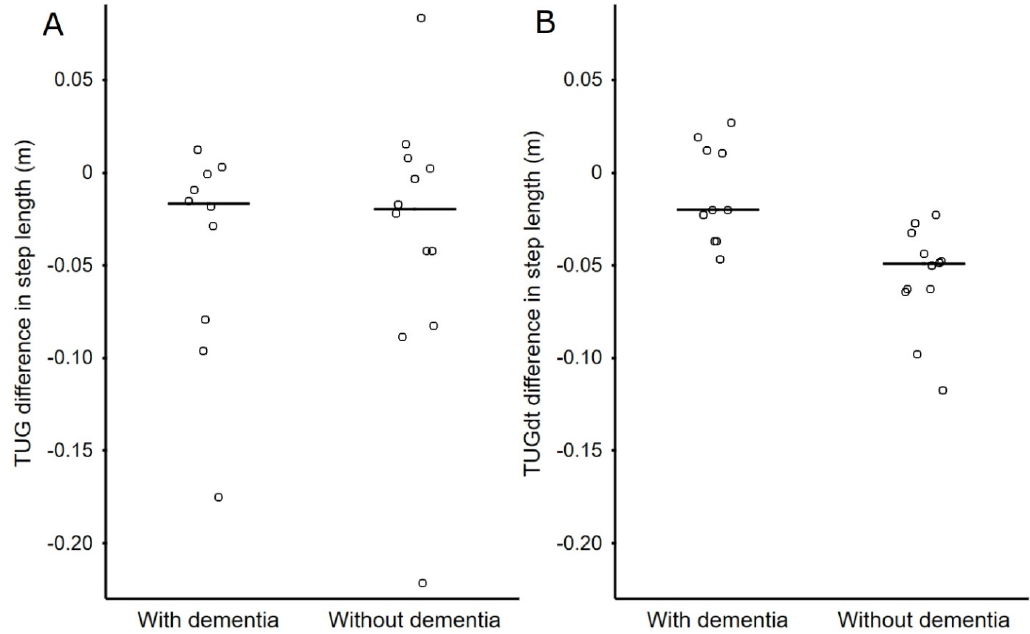
Figure 2. Difference in step length after vs. before turning in Timed Up-and-Go ( A ) and Timed Up-and-Go dual-task ( B ) tests among individuals with a dementia disorder diagnosis and no established dementia disorder diagnosis. Horizontal lines on the graphs show median value.